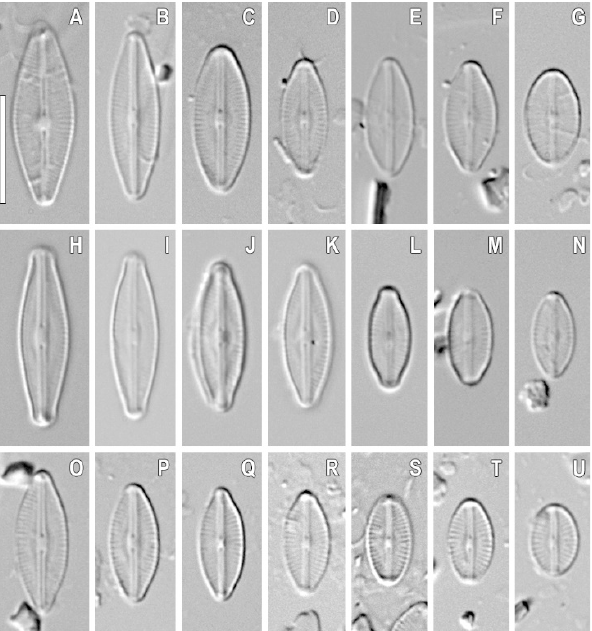
Figure 5. Sellaphora terrestris sp. nov. Light microscopy, differential interference contrast, size diminution series. Samples of wild populations. ( A – G ). Sample Kt33. Slide no 07223. ( H – N ). Sample Kt59. Slide no 06989. ( O – U ). Sample Kt60. Slide no 07232. Scale bar = 10 μ m.